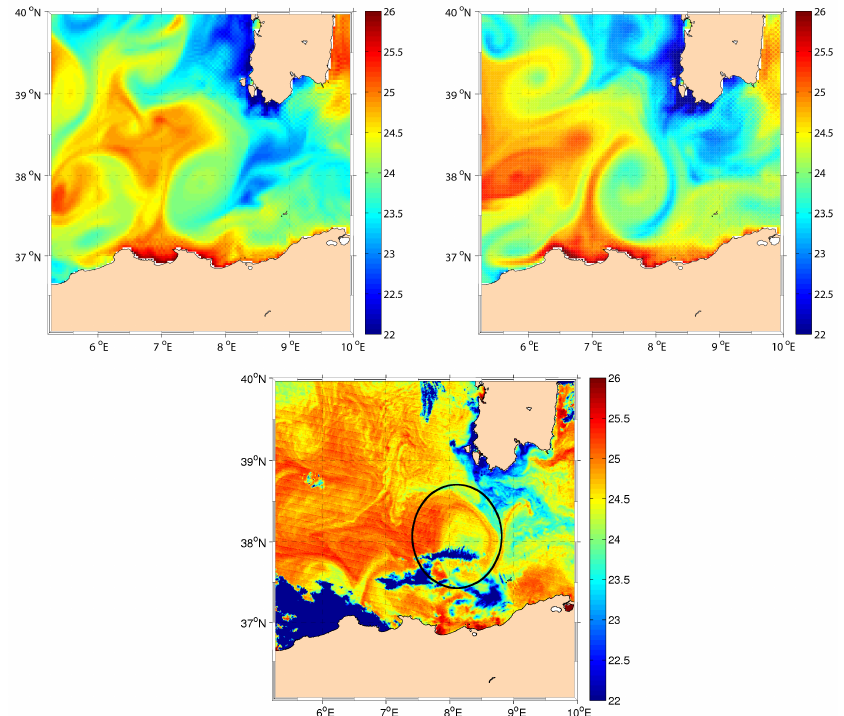
Figure 10. SST for BF (left), BFC experiments (right) and MODIS SST L2 (bottom panel) for 29 June 2012. Anticyclone is circled in black. Units are ◦ C